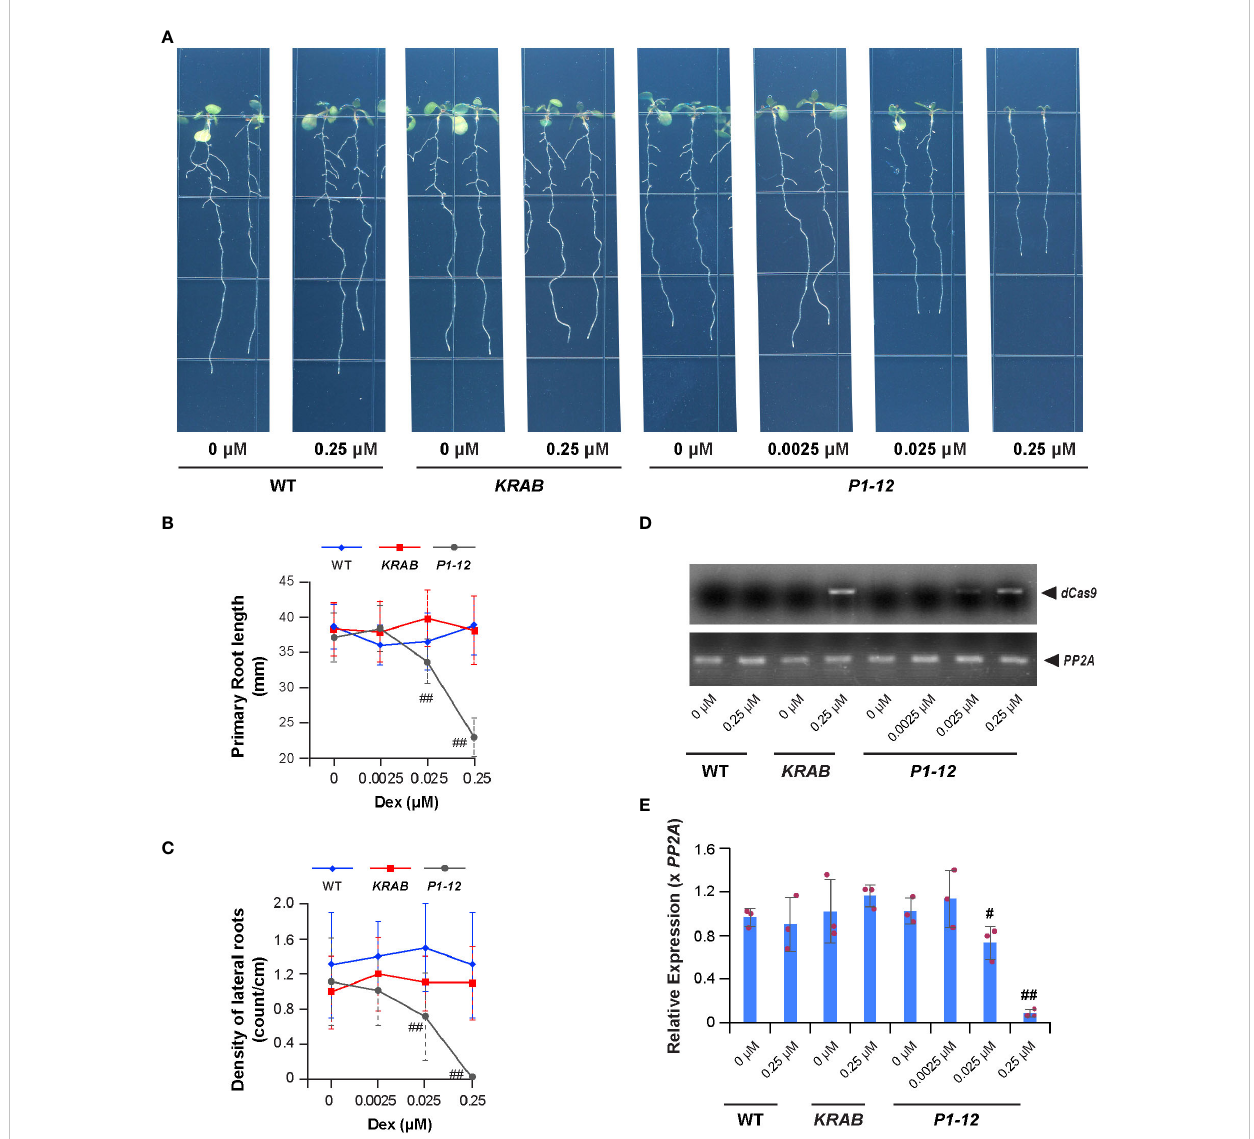
FIGURE 2 A MORF2 dosage-dependent growth inhibition. (A) Representative images showing seedlings from indicated genotypes grown vertically for 8 d under LD on 1/2 MS media supplemented with different concentrations of Dex. (B, C) Dex treatment inhibits primary (B) and lateral (C) root growth of P1-12 but not KRAB . The seedlings shown as in (A) were scanned and measured for primary root length using NeuronJ plugin in ImageJ. Visual lateral root number was counted manually. The density of lateral roots was normalized by the primary root length. (D) sqRT-PCR identi fi es the expression of dCas9-KRAB gene in seedlings of KRAB (+0.25 m M Dex) and P1-12 (+0.025/0.25 m M Dex). PP2A amplicons were shown to indicate a similar input of cDNA templates among different samples. (E) Dex treatment inhibits MORF2 expression in P1-12 at a concentration as low as 0.025 m M. Relative expression (mean ± SD) was normalized to PP2A from three biological replicates, each with three technical replicates. All data points were further normalized to one of the three biological replicates of WT seedlings grown under the DMSO treatment. The data points of replicates in each bar are indicated with maroon dots. P values were calculated using Student ’ s t -test. # and ##: P (< P1-12 (+DMSO)) < 0.05 and 0.01,